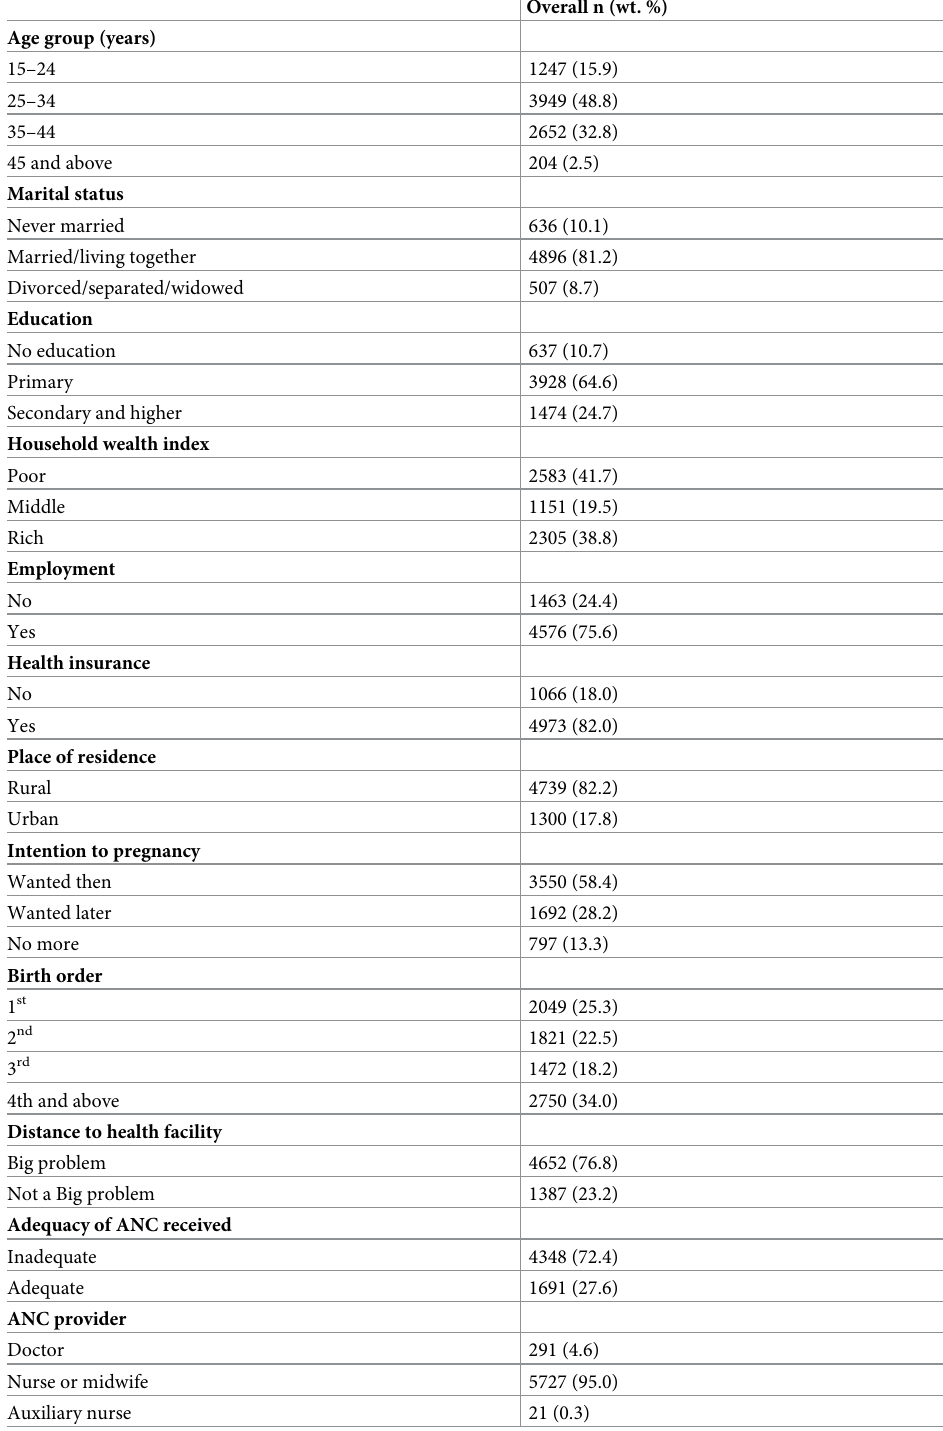
Table 1. Demographic characteristics of the respondents (n =